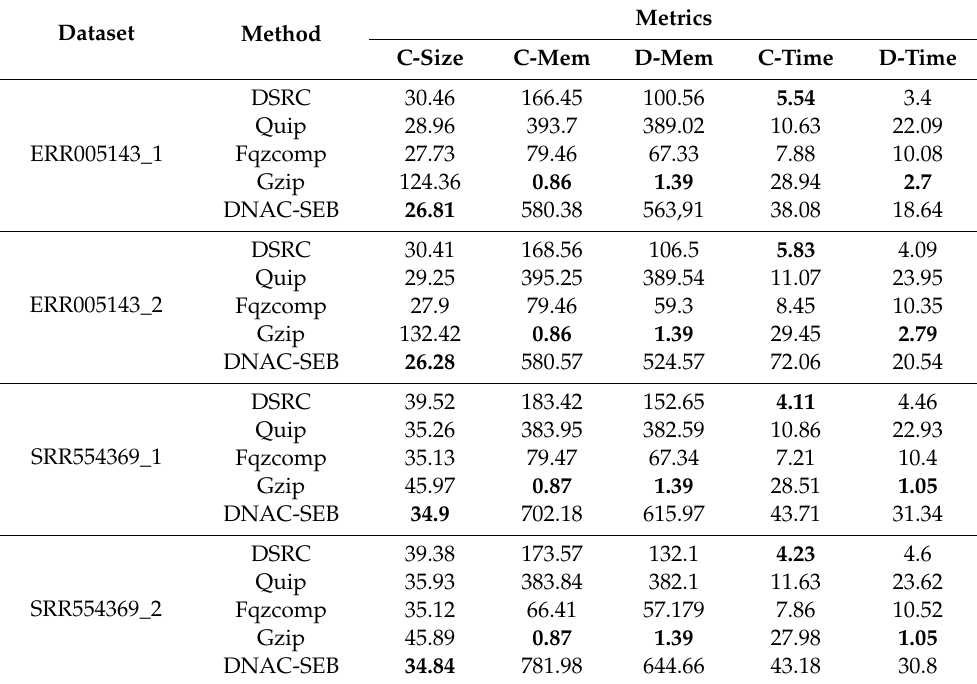
Table 9. Comparison of compressed data size, processing time and memory utilization using FASTQ